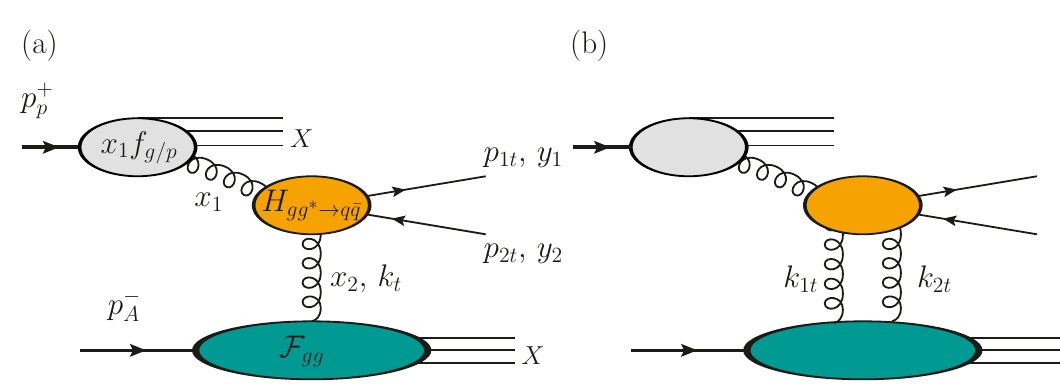
Figure 1 . Amplitude-level diagrams for forward quark dijet production p ( p p ) + A ( p A ) → q ( p 1 ) + ¯ q ( p 2 )+ X from the point of view of the ITMD framework. (a): squaring the amplitude provides the q ¯ q dijet production cross section in the ITMD framework. (b): diagram yielding so-called genuine- twists corrections, O ( Q s / | P t | ) , neglected in the ITMD formula but included in the CGC